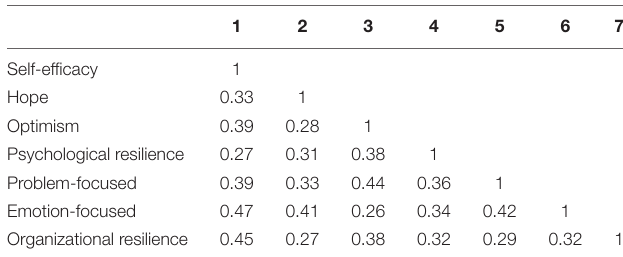
TABLE 3 | Correlation of the